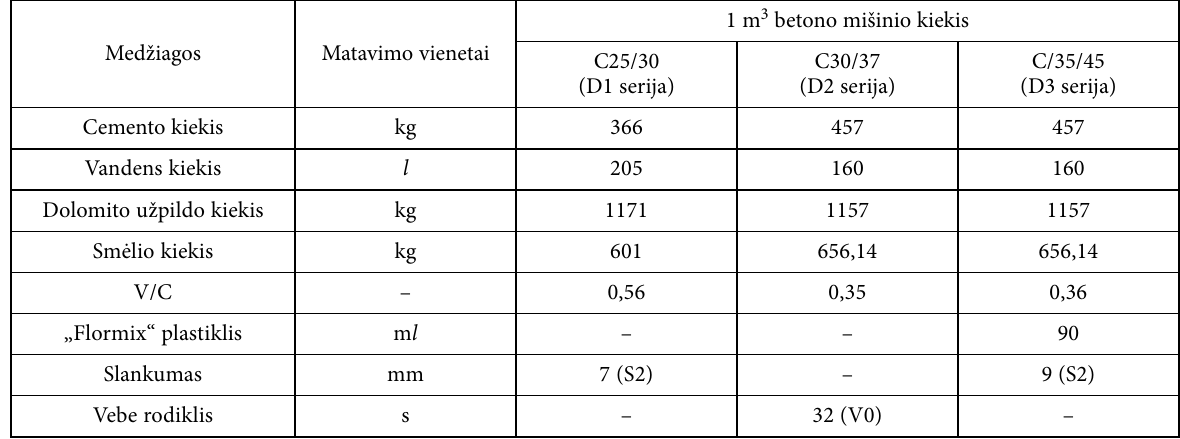
Table 1 . The composition of investigated concrete